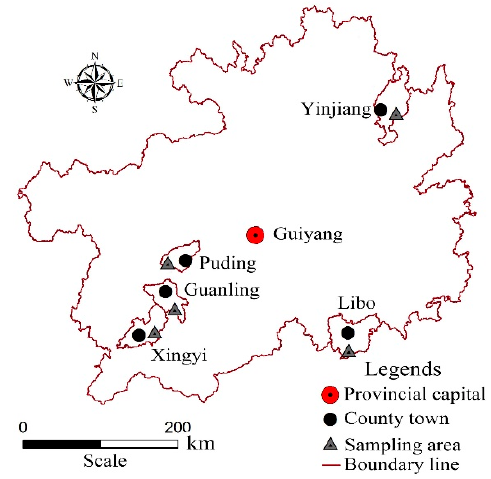
Figure 1. Distribution of sampling points.